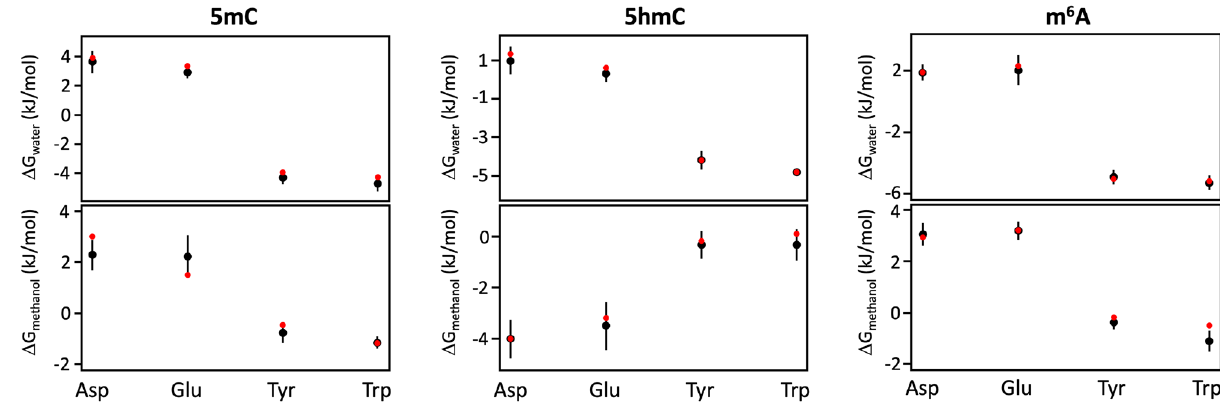
Figure 4. Convergence analysis. Means and standard deviations of ΔG binding of select protein side chains (Asp, Glu, Tyr, Trp) for ( a ) 5mC, ( b ) 5hmC and ( c ) m 6 A, derived from 5 independent simulations runs in water and methanol. Red dots represent the values of ΔG binding reported in Tables 1 and